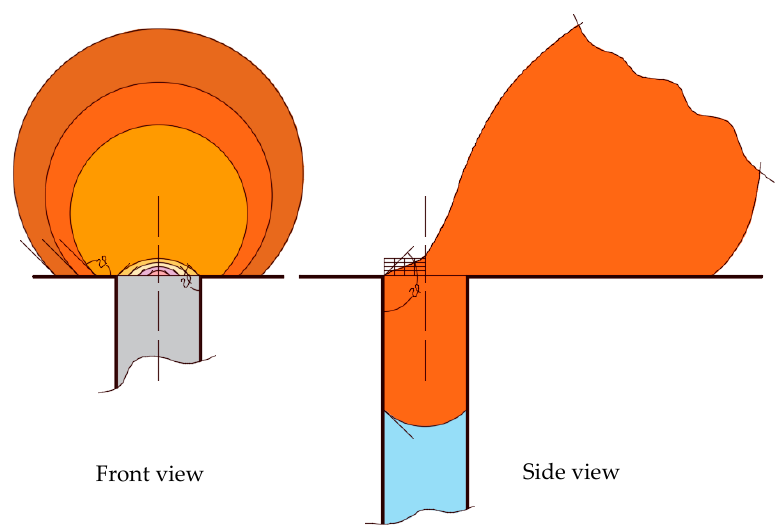
Figure 7. The critical configuration is achieved when the contact angle of the receding interface assumes the static contact angle. Any further deformation will lead to the breakup of the droplet. The front view shows the projection of the droplet at the frontal cross-section and the side view depicts the deformation of the droplet due to the crossflow field.